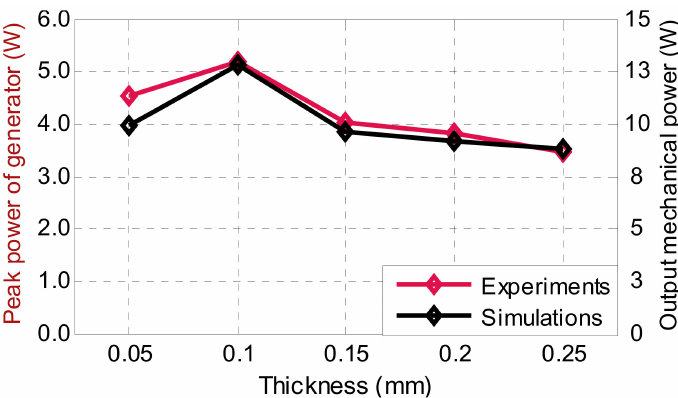
Figure 23. Comparison of power obtained in experiments and numerical simulations.